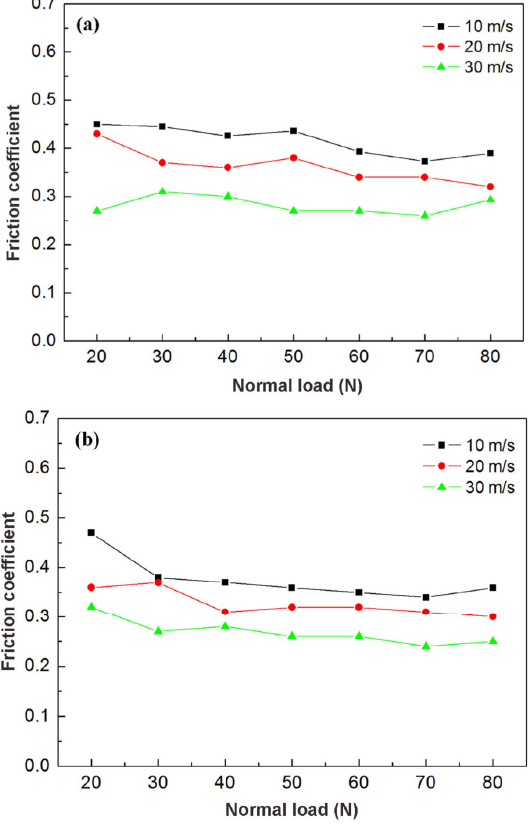
Fig. 6 Friction coefficients of (a) Ti 2 AlC and (b) Ti 2 AlSn 0.2 C sliding against low-carbon steel at different sliding speeds as a function of normal load.